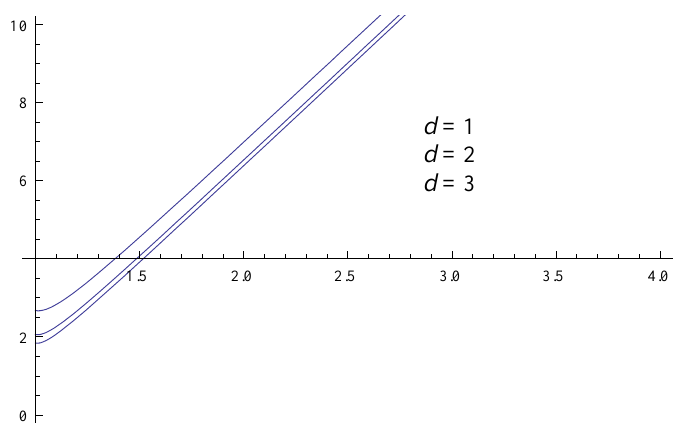
Figure 4. The impact of parameter d on the MRL of C ( k,d,n )